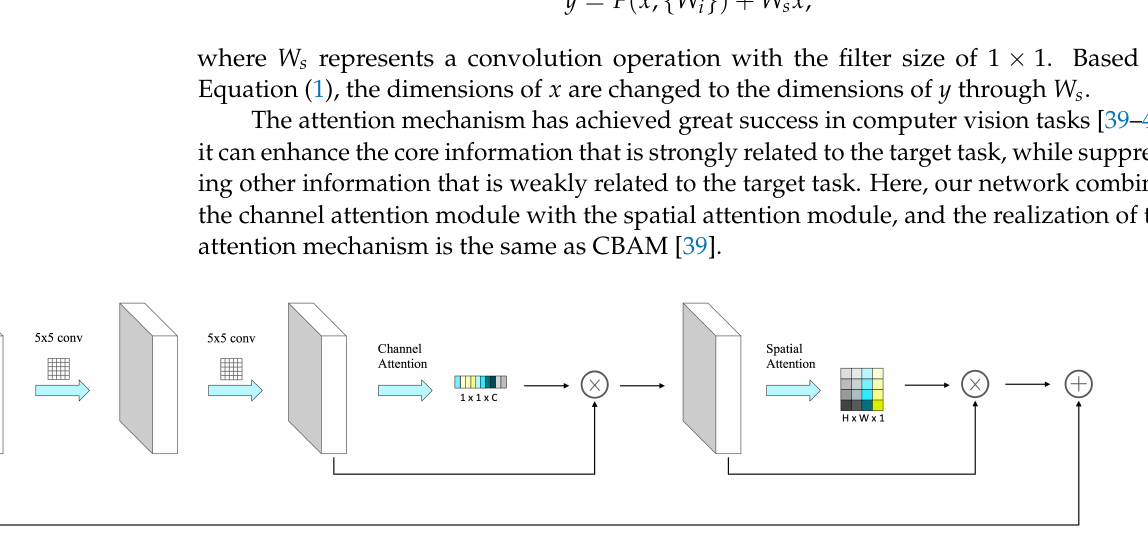
Figure 2. The illustration of the residual block with embedded attention. It combines residual learning with the atten- tion